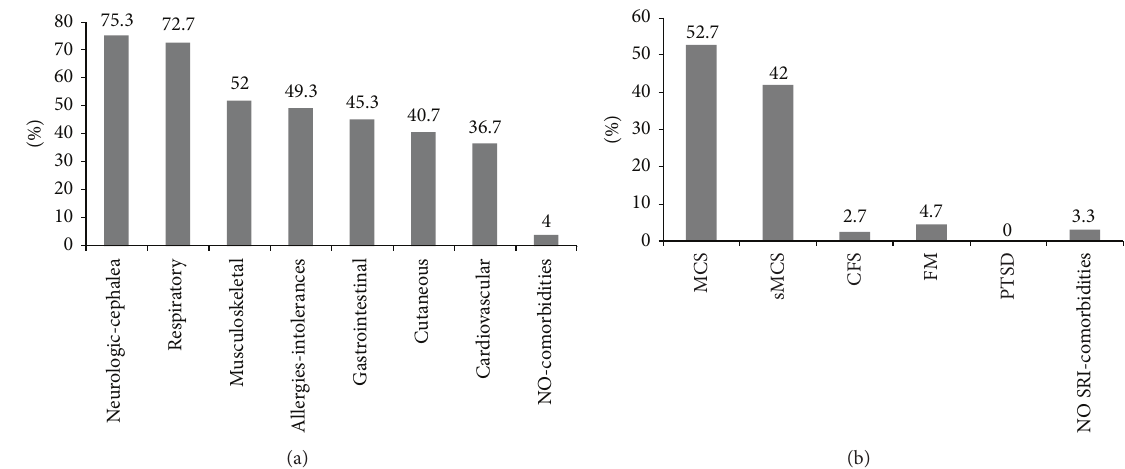
Figure 3: Distribution of specific organ comorbidities (a) and sensitivity-related illness-SRI comorbidities (b) registered in the case history of the group of patients self-reporting electromagnetic hypersensitivity (EHS, 𝑛 = 153 ). Data are expressed as percentage of the total patient group, for patients affected by each single category of organ pathologies (a), and by each SRI (b), specifically multiple chemical sensitivity (MCS) or suspected MCS (sMCS), chronic fatigue syndrome (CFS), fibromyalgia (FM), and posttraumatic stress disorders (PTSD).